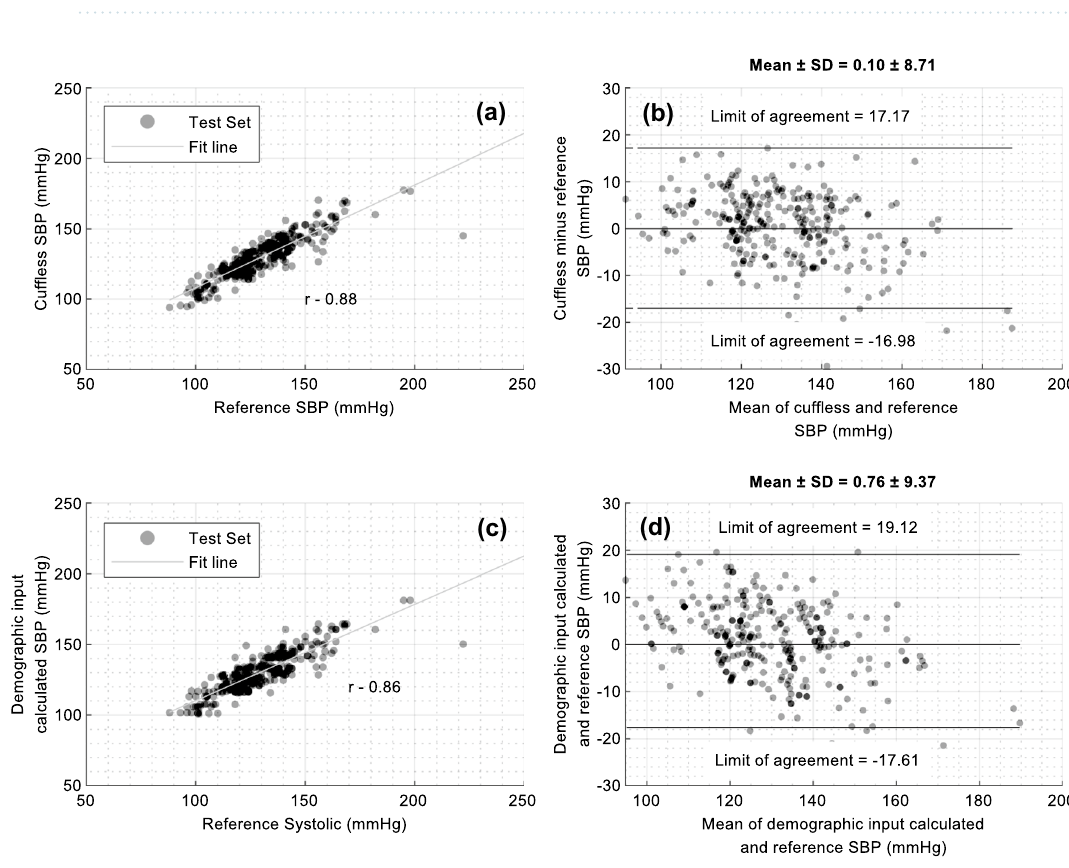
Figure 7. Comparison of actual and predicted measures of Systolic blood pressures from the SimpleSense-BP cuffless model and a baseline model that uses only demographics data. ( a ) scatter plot of predicted vs actual SBP for test set only for SimpleSense-BP device with the correlation coefficient ( b ) Bland Altman plot for test set with limits of agreement and the mean and standard deviation of errors compared to the reference measurement ( c ) scatter plot of predicted vs actual SBP on test set only for baseline model ( d ) Bland Altman plot on test set only with limits of agreement and the mean and standard deviation of errors compared to the reference measurement for the baseline